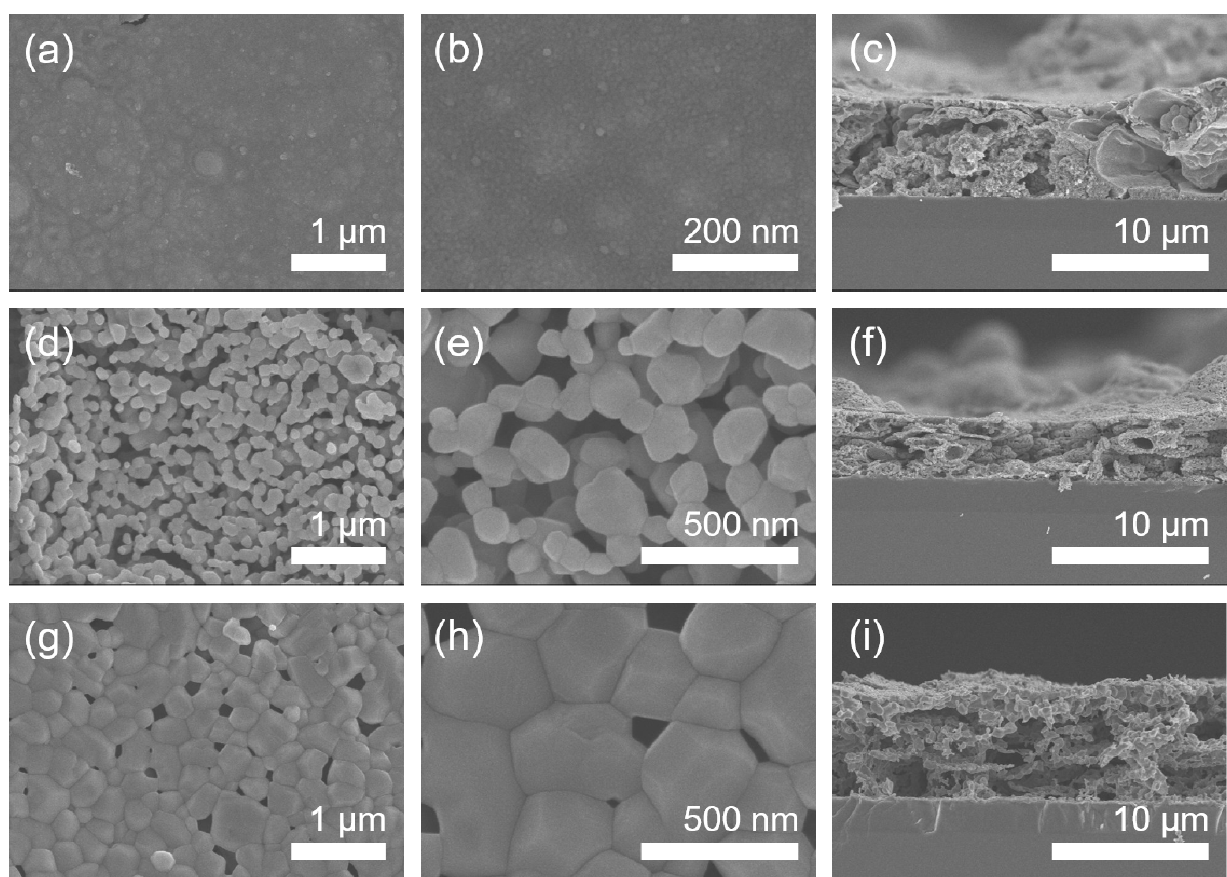
Figure 4. FE-SEM micrographs of the manganese oxide (Mn 2 O 3 ) films. ( a ) The low-magnification and ( b ) high-magnification top-view images and ( c ) cross-sectional image of 400 °C-calcinated films on SiO 2 /Si substrates in air. ( d ) The low-magnification and ( e ) high-magnification top-view images and ( f ) cross-sectional image of 800 °C-calcinated films in air. ( g ) The low-magnification and ( h ) high-magnification top-view images and ( i ) cross-sectional image of 1000 °C-calcinated films in air.